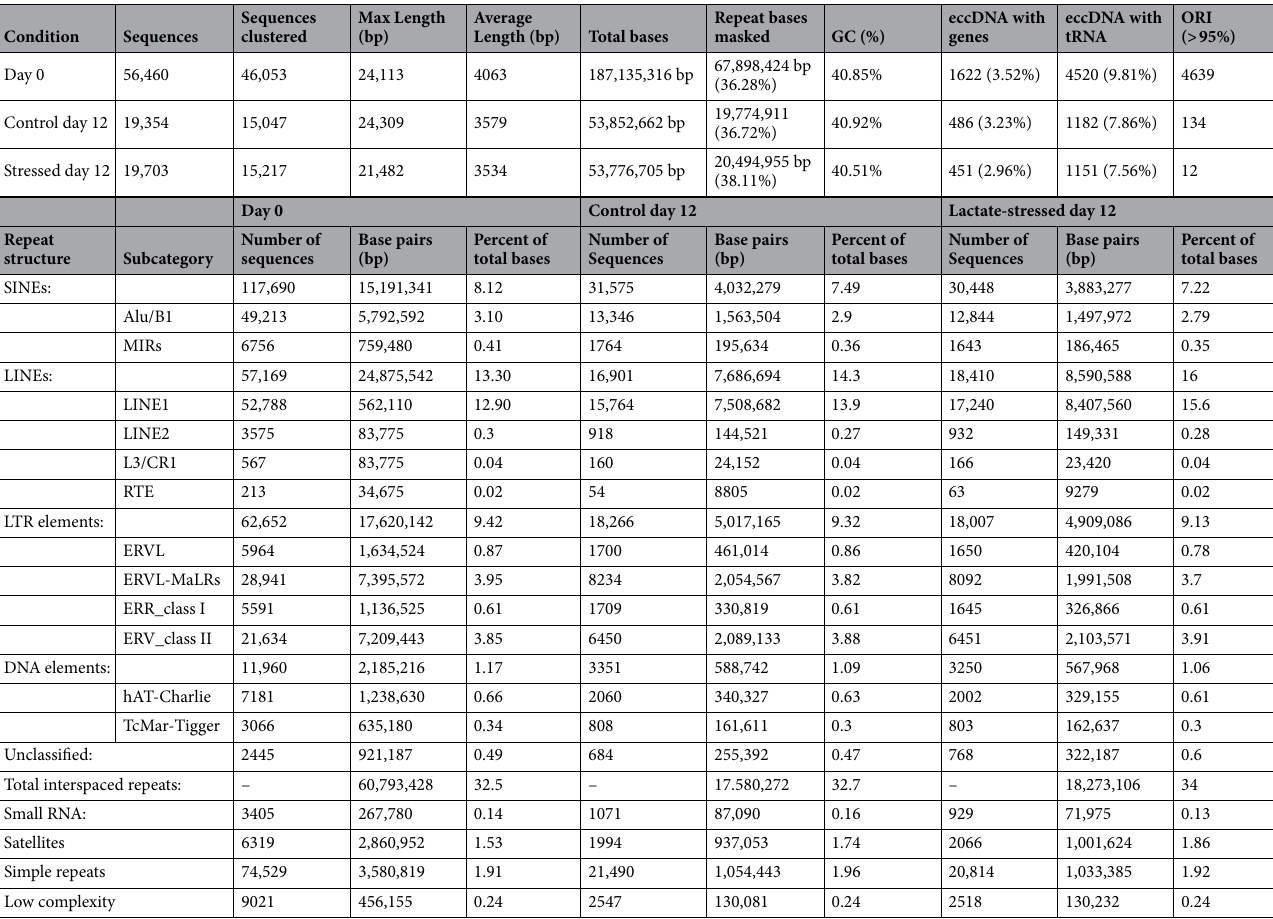
Table 1. Sequence characteristics for eccDNA sequences from control and lactate-stressed cultures including repetitive motif content, gene content, tRNA content, and potential origins of replication. Sequences were grouped by condition and clustered for similarity (> 90%). The Day 0 samples include all four bioreactors, while Day 12 samples include duplicate bioreactors for control and lactate-stressed